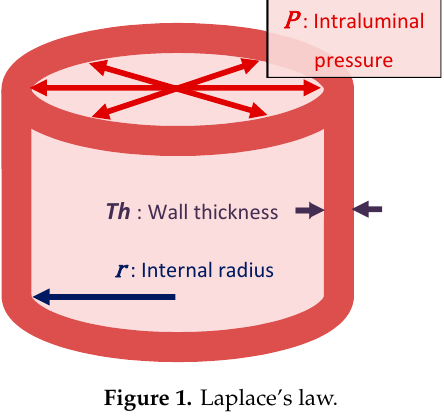
Figure 1. Laplace’s law.